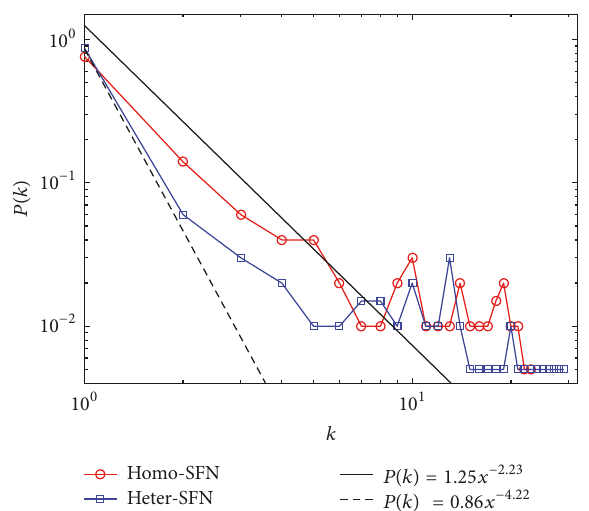
Figure 4: Degree distribution of homogeneous scale-free network and heterogeneous scale-free